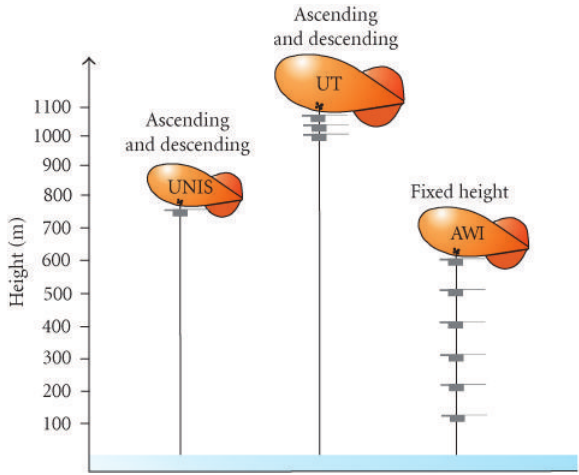
Figure 2: Schematic figure on the tethersonde sounding systems of the University Centre in Svalbard (UNIS), University of Tartu (UT), and Alfred Wegener Institute (AWI). The size of balloons is not in the scale of the vertical axis.